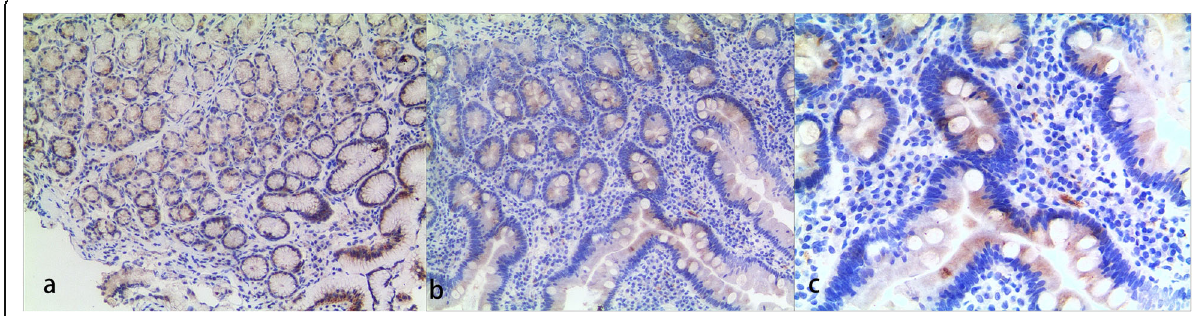
Fig. 2 DGAT1 protein expression in the proband. a Immunohistochemistry of DGAT1 in the proband ’ s biopsy of the gastric antrum (× 100). b Immunohistochemistry of DGAT1 in the proband ’ s biopsy at the duodenum (× 100). c Immunohistochemistry of DGAT1 in the proband ’ s biopsy at the duodenum (×